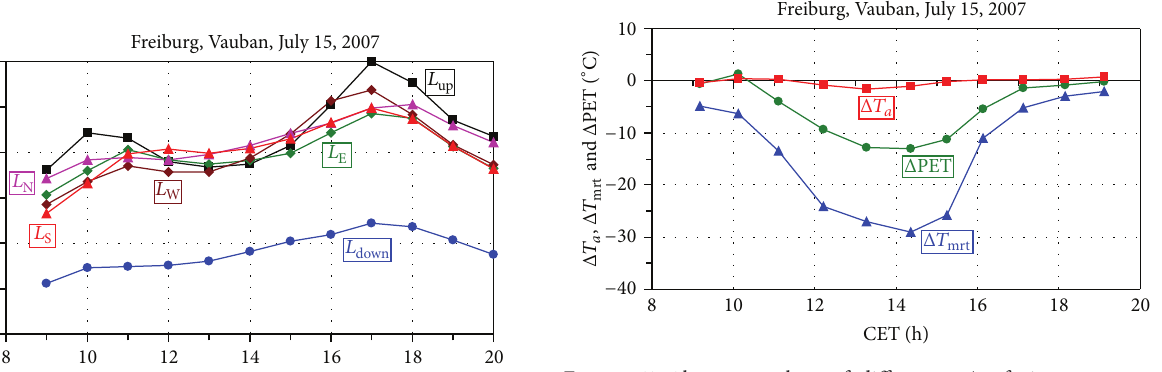
Figure 11: 1h mean values of differences Δ of air temperature 𝑇 𝑇 , and physiologically equivalent 𝑎 , mean radiant temperature mrt temperature PET between the shaded NNE- and sunny SSW- Figure 9: 1h mean values of the long-wave radiant flux densities 𝐿 𝑖 facing sidewalk of a WNW-ESE street canyon, “Vauban” quarter in ( 𝑖 = down, up, E, S, W, and N) reaching the human-biometeoro- Freiburg during typical Central European summer logical reference person from the three-dimensional environment, ( 𝐿 = 533 W/m 2 ), NNE- related to the 1h peak value of 𝐿 up up , max facing sidewalk of a WNW-ESE street canyon, “Vauban” quarter in Freiburg during typical Central European summer day.